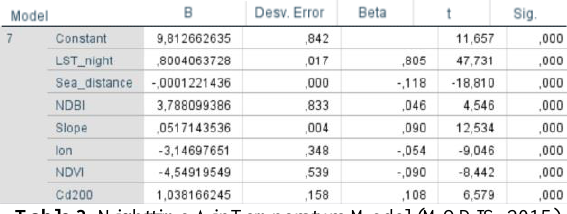
Table 3. Nighttime Air Temperature Model (MODIS, 2015)